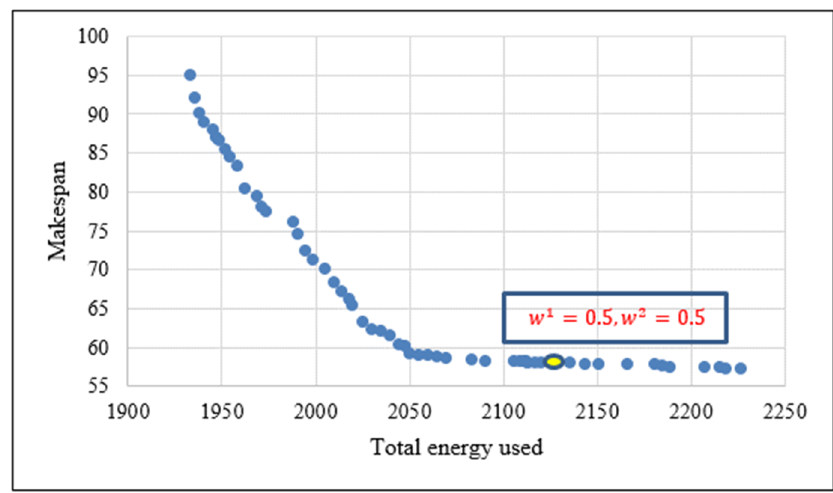
Figure 5. Pareto front of DE.